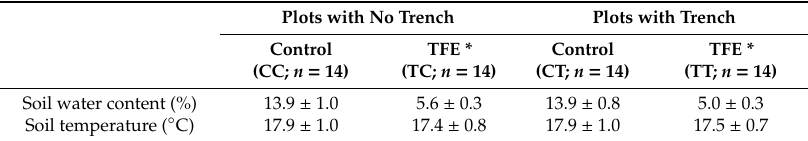
Table 1. Mean soil water content and temperature with standard errors (Avg. ± S.E.) in the control and throughfall exclusion (TFE) plots with and without trenches under the TFE experiment (from 26 April to 20 October